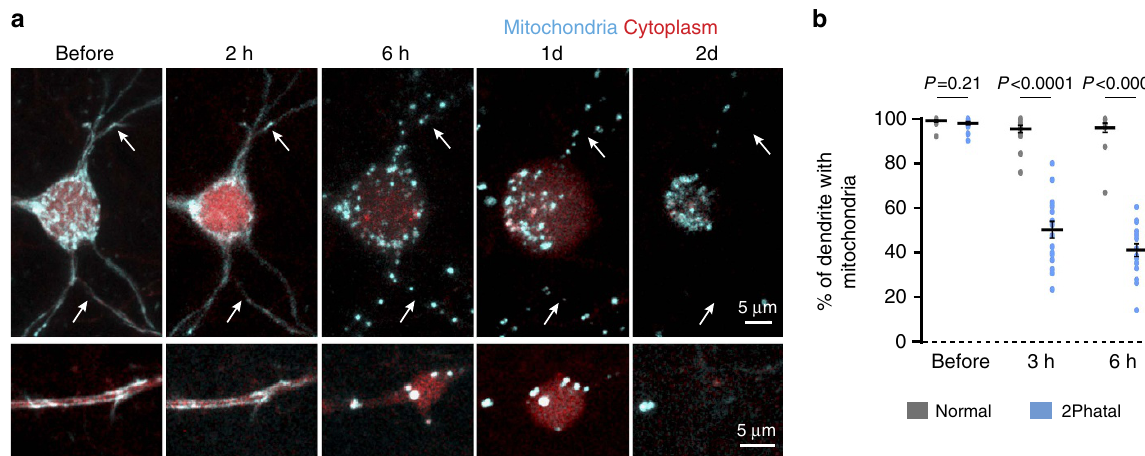
Figure 6 | Mitochondrial fission during apoptosis. ( a ) In vivo time-lapse sequence showing mitochondrial fission occurring in cell soma and dendrites between 2 and 6h after photobleaching. Arrows indicate the location of the same dendritic branch for each time point. ( b ) Quantification of mitochondria fission in normal vs photobleached cells based on changes in the percentage of single stretches of dendrite filled with mitochondrial fluorescence labelling; significance determined by multiple t -tests with Holm–Sidak correction, before P ¼ 0.21, t ¼ 1.286, df ¼ 31; 2h, P o 0.0001, t ¼ 10.76, df ¼ 31; 6h, P o 0.0001, t ¼ 15.35, df ¼ 31, as indicated. Normal n ¼ 14 dendrites from 3 mice, 2Phatal n ¼ 15 dendrites from 3 mice (df ¼ degrees of